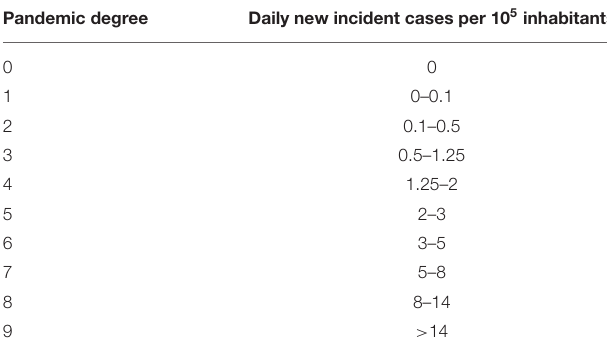
TABLE 1 | Biocom-Cov scale to assess the epidemic degree of a